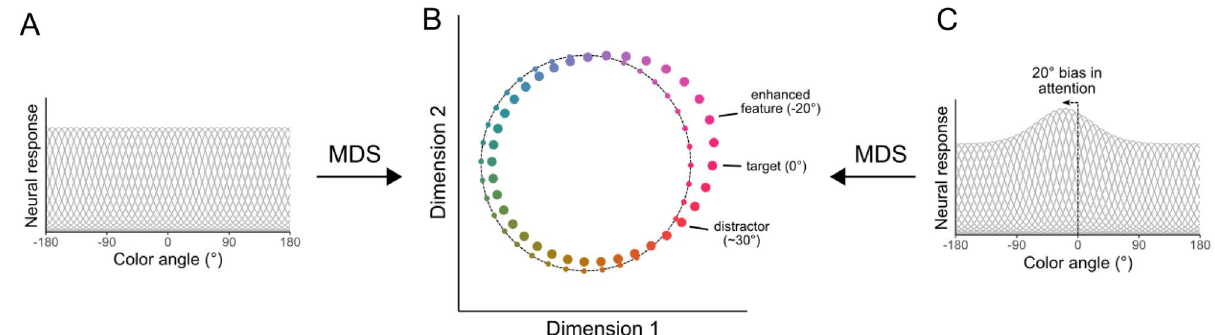
Figure 3. ( A ) Hypothetical neural population representing a circular feature space. ( B ) Multidimensional scaling (MDS) of the population results in a circular representational geometry (small circles overlayed on dashed line). Points in MDS space were subsampled to represent colors 10° in the feature space. ( C ) Neural population with simulated attentional gain applied at 20° from the true target position (0°), resulting